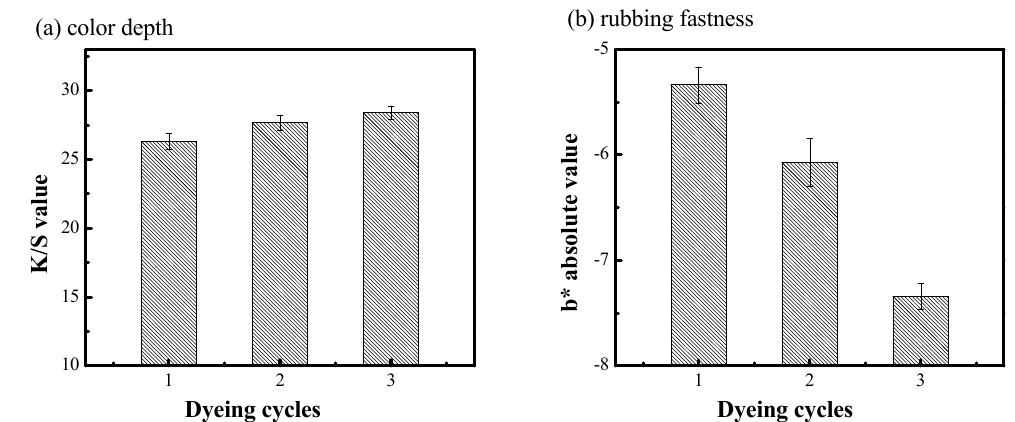
Figure 4. Effect of dyeing cycles on the color depth ( a ) and rubbing fastness of dyed cotton fiber ( b ).